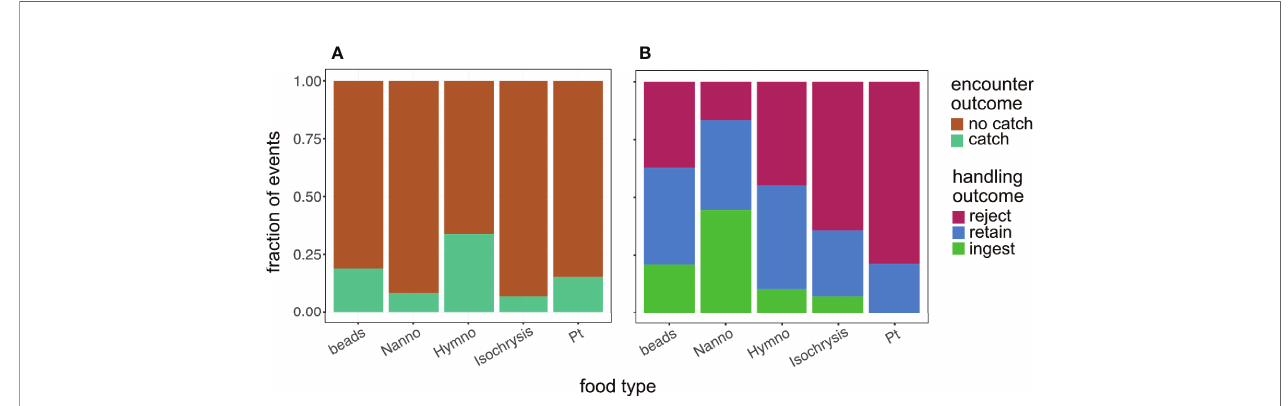
FIGURE 6 | Encounter and handling outcome ( A, B , respectively) by food type for Climacocilys scalaria . n = 817 and 137 for encounters and handling events. Caught particles were either rejected back into the fl uid, ingested into the cell, or remained in the oral cavity by the end of our video ( ‘ retained ’ ). Overall feeding success was 0.07. ‘ Beads ’ are Polysciences Fluoresbrite carboxylate microspheres, ‘ Nanno ’ - Nannochloropsis oceanica, ‘ Hymno ’ - Hymenomonas sp., ‘ Isochrysis ’ - Isochrysis galbana , ‘ Pt ’ - Phaeodactylum